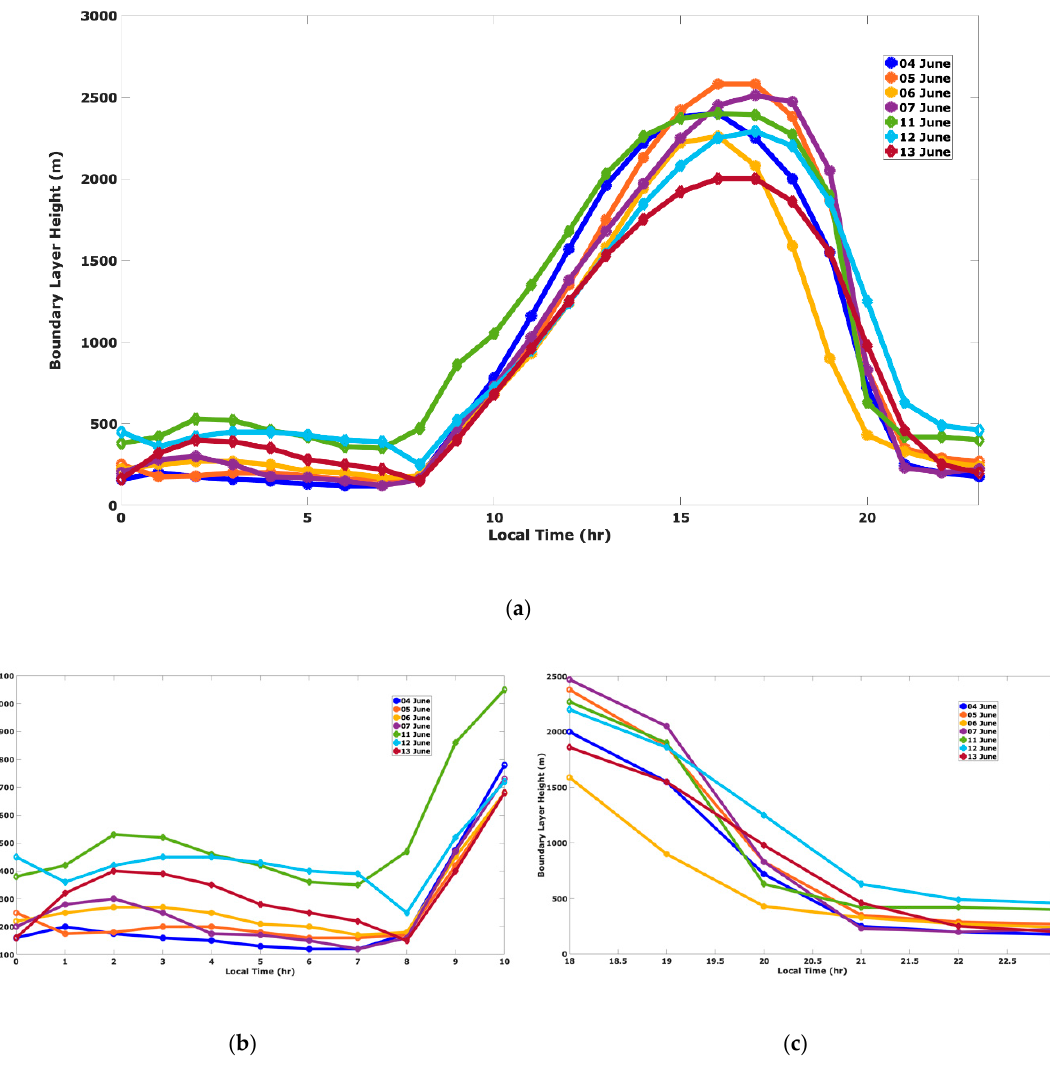
Figure 12. ( a ) WRF-generated planetary boundary layer height (PBLH) plots for high ozone days (4–7 June 2017) and low ozone days (11–13 June 2017) using the Yonsei University Scheme (YSU) scheme; ( b ) the PBLH in the early morning; and ( c ) the PBLH in the late evening.